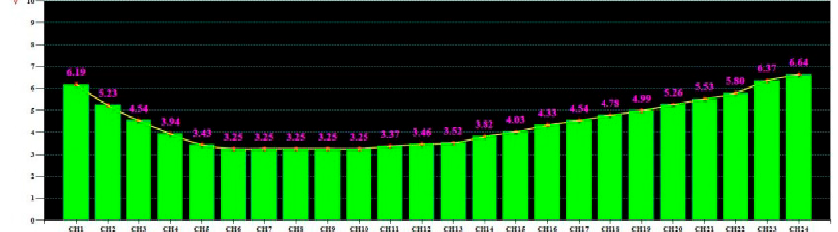
Figure 15. Shape signal detected by sensors embedded in the roll body at a rolling time of 1005 s.